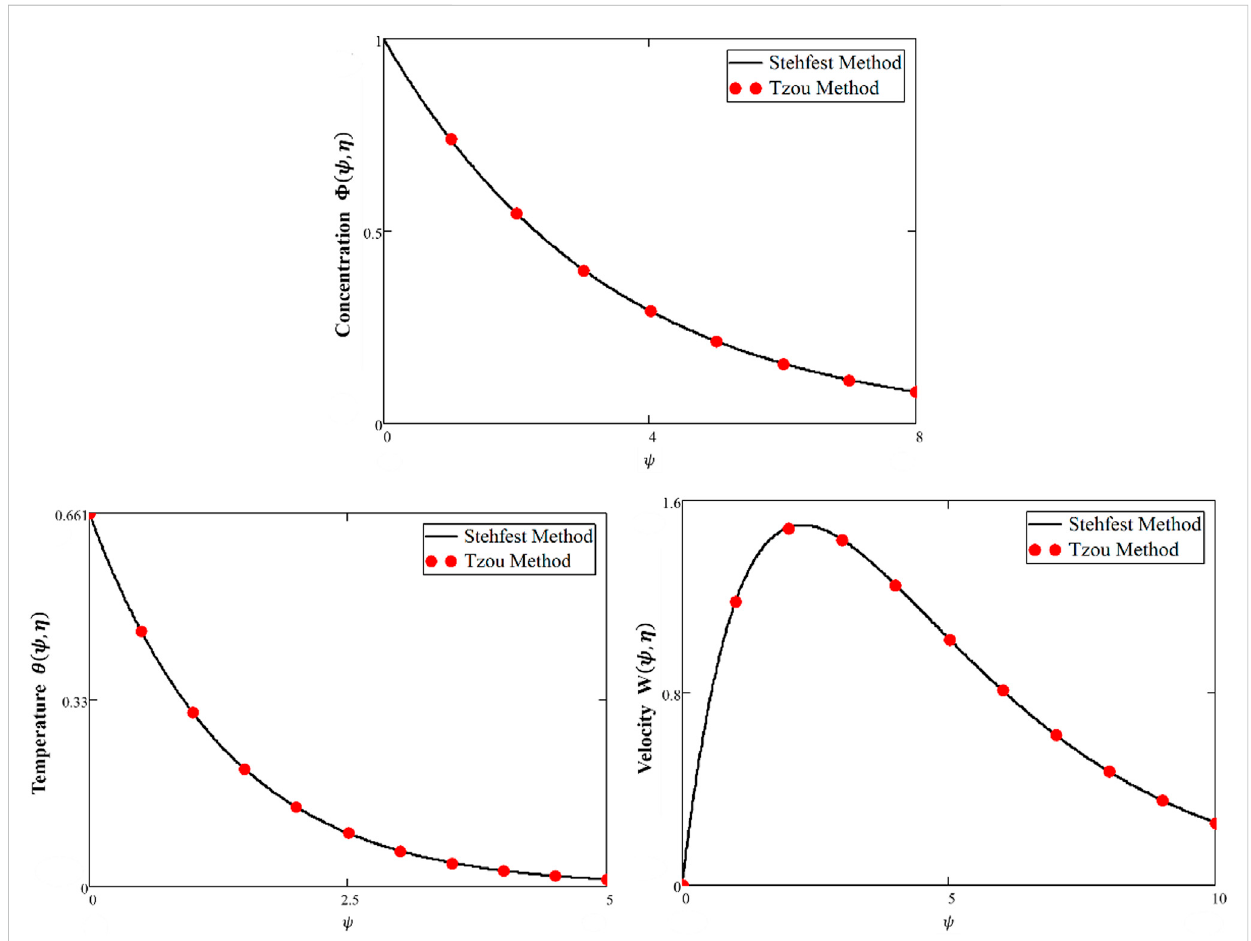
FIGURE 14 Simulation to explain the concentration, temperature, and velocity for the comparison of different inversion numerical algorithms.